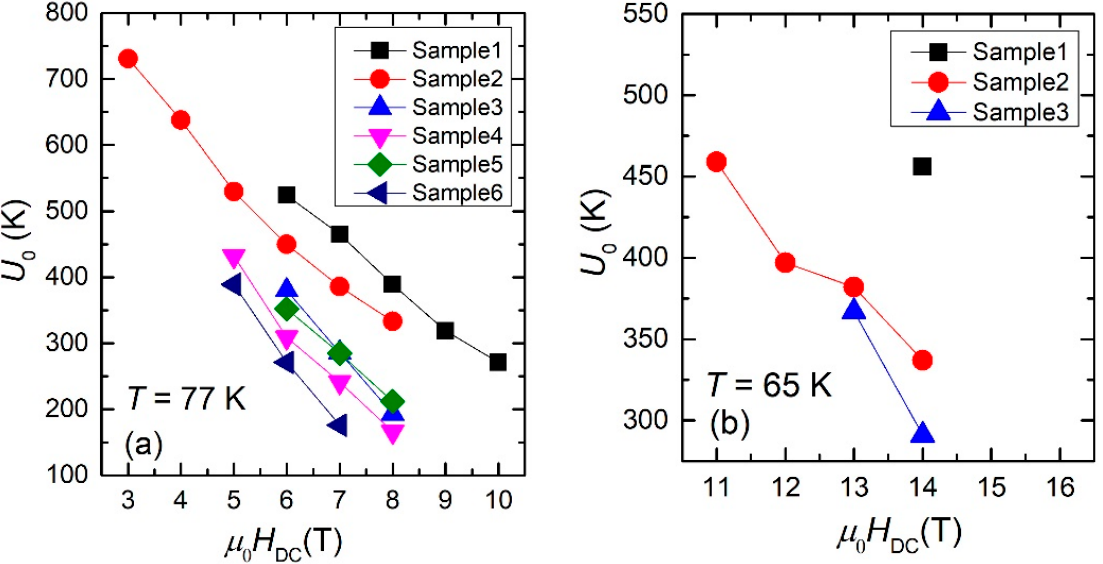
Figure 7. Estimated values of the pinning potential in various DC fields. ( a ) T = 77 K, ( b ) T = 65 K